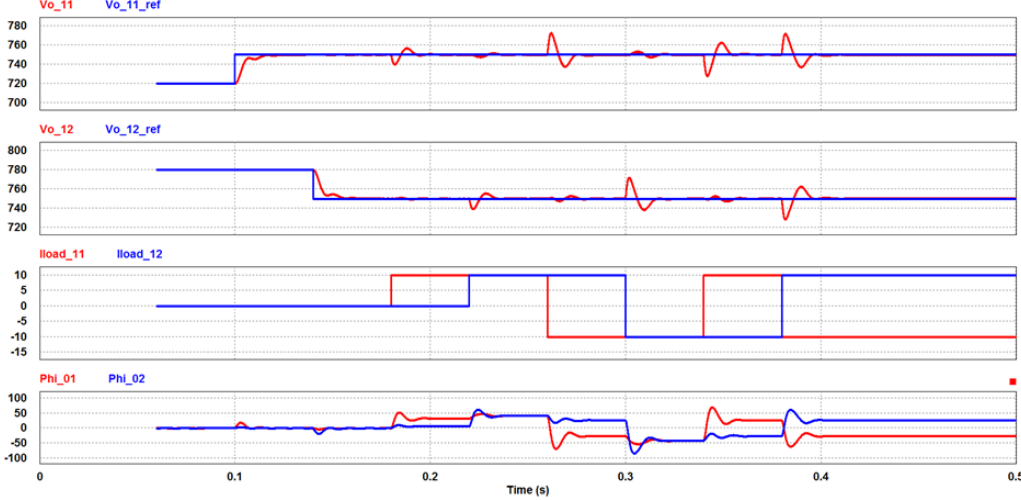
Figure 12. Simulation waveform to verify the decoupling capability of the DC/DC